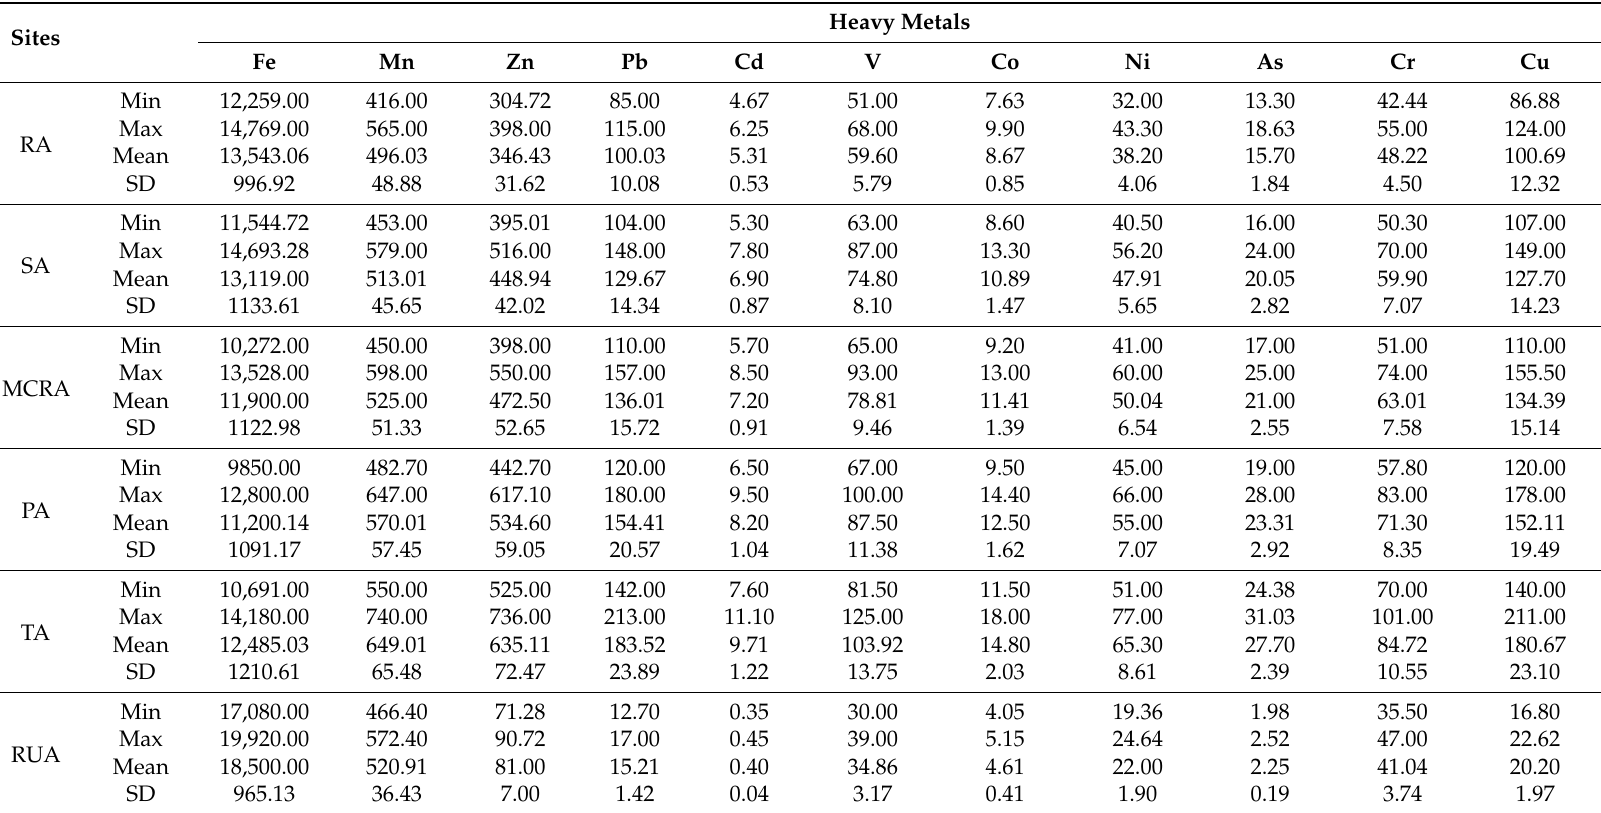
Table 3. Concentrations (mg/kg) of heavy metals in road dusts of different functional